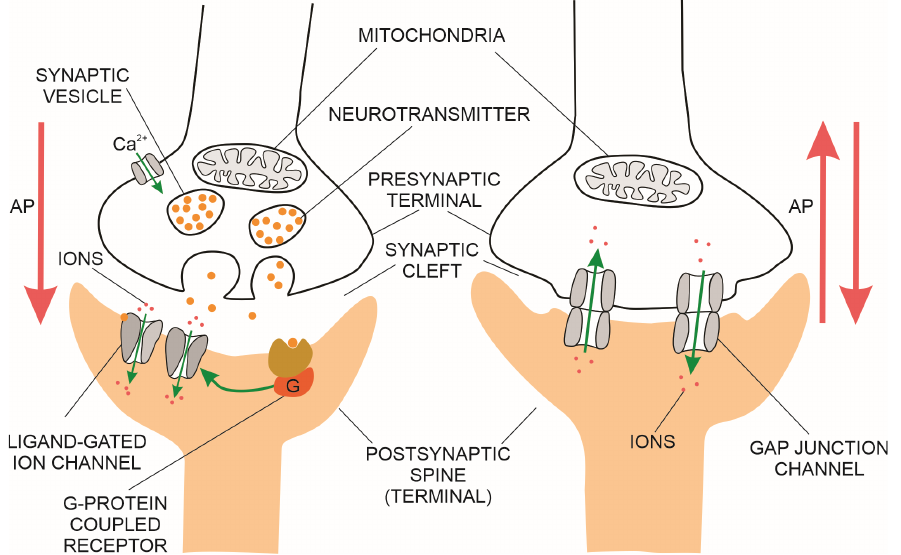
Figure 3. Chemical synapse ( left ) and electrical synapse ( right ). The AP with red arrows represents the direction of action potential transmission.